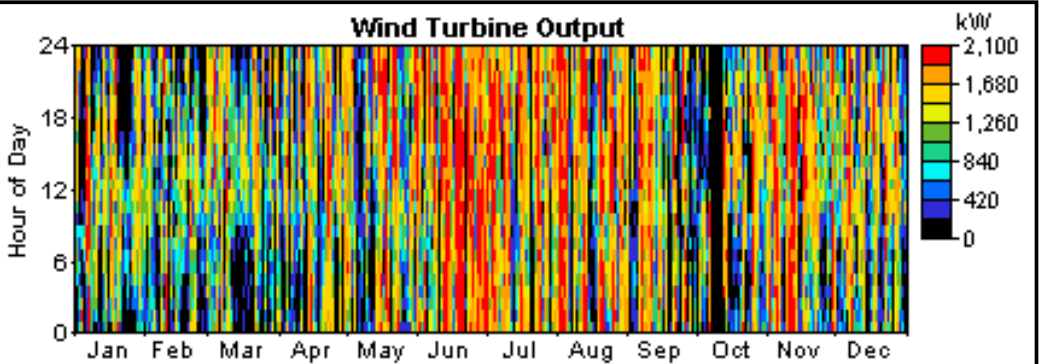
Figure 7. Daily wind turbine power output over a 12 month